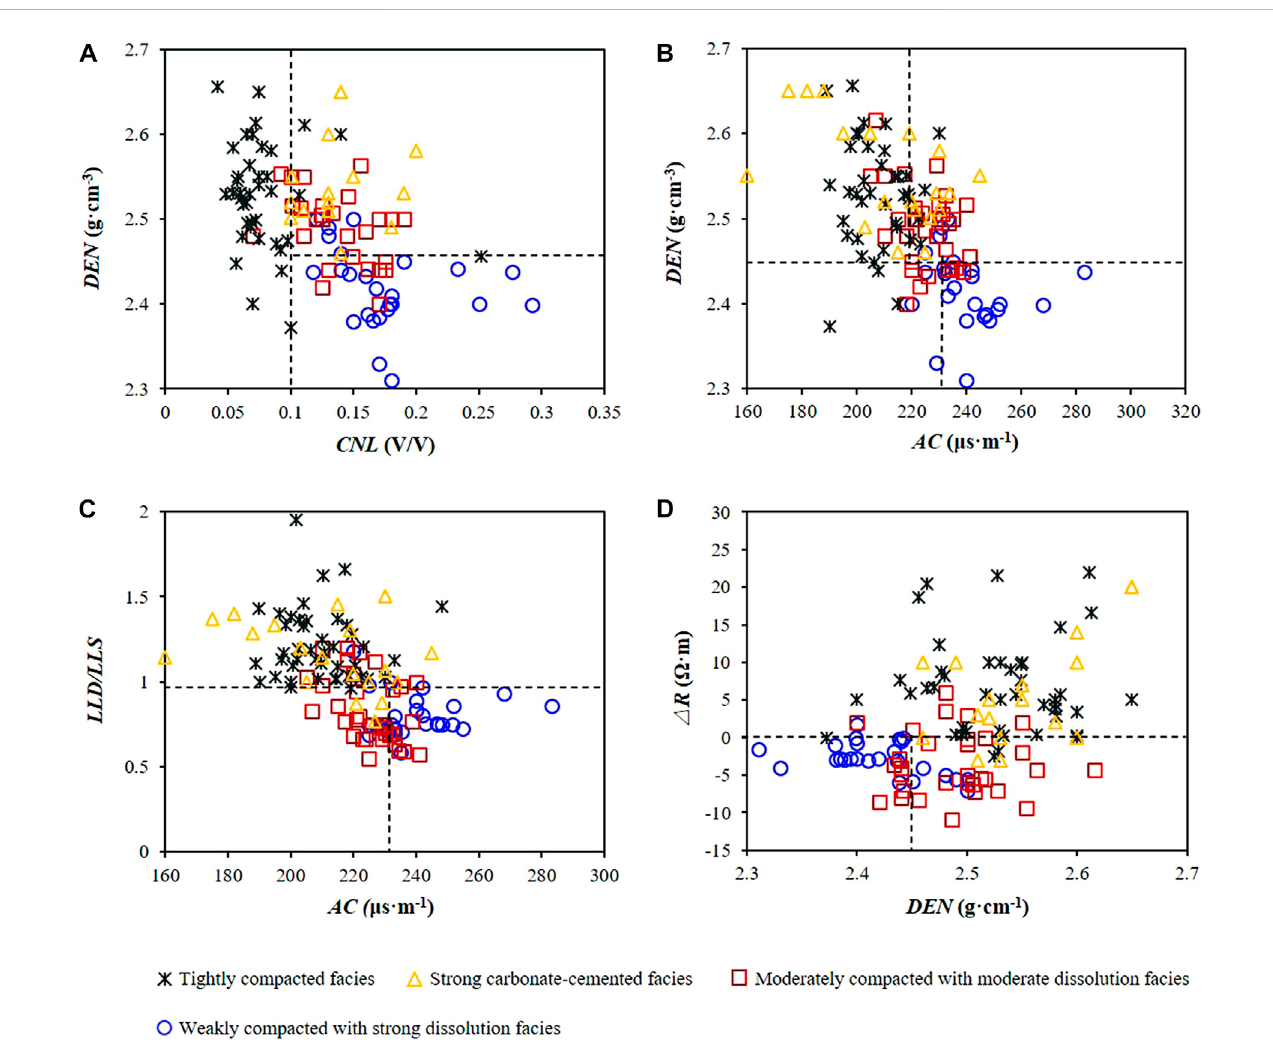
FIGURE 11 Cross plots showing logging parameters of different types of diagenetic facies of the J 2 x 1+2 sandstone reservoirs. DEN- bulk density log; CNL- compensated neutron log; AC- acoustic transit time log; LLD- deep lateral resistivity log; LLS- shallow lateral resistivity log; LLD/LLS- the ratio of deep lateral resistivity log to shallow lateral resistivity log; Δ R =